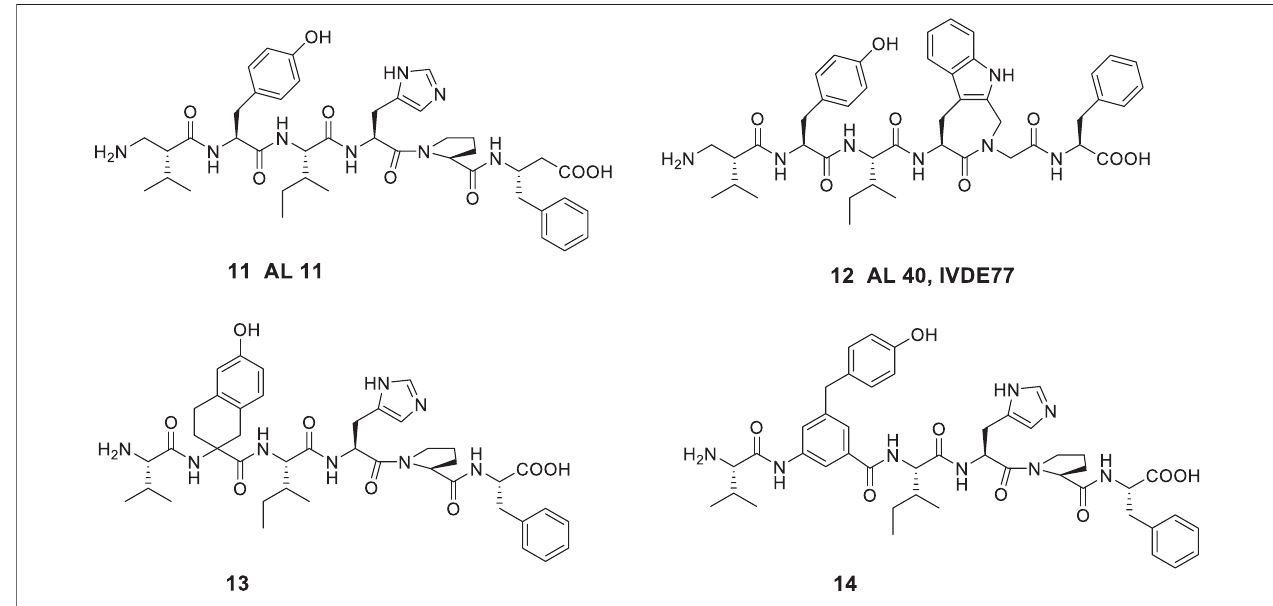
Figure 4 | The high af fi nity and metabolically stable IRAP inhibitors 11 (AL-11) and 12 (AL-40) both comprising β amino acid residues. The compounds 13 and 14 where the Tyr 2 residue is replaced are inactive as IRAP inhibitors.